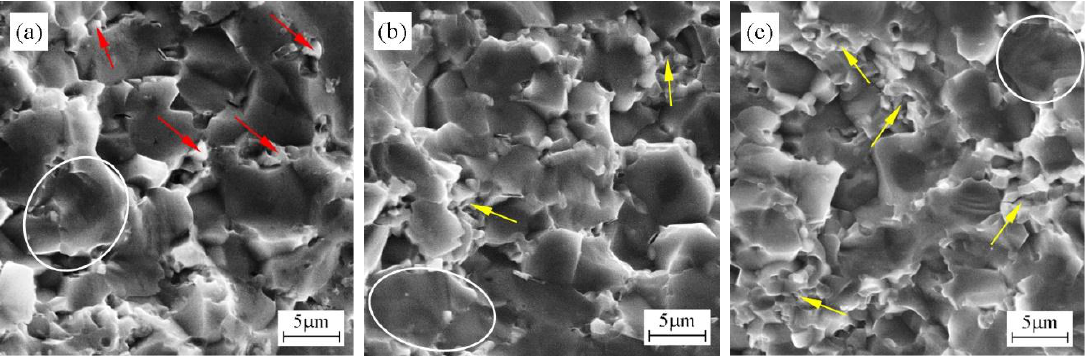
Figure 4 . Fracture morphologies of the fracture surface of ZrB 2 –HfC ceramics with different HfC content: ( a ) ZrB 2 –10 wt % HfC (ZH10N), ( b ) ZrB 2 –20 wt % HfC (ZH20N), and ( c ) ZrB 2 –30 wt % HfC (ZH30N).